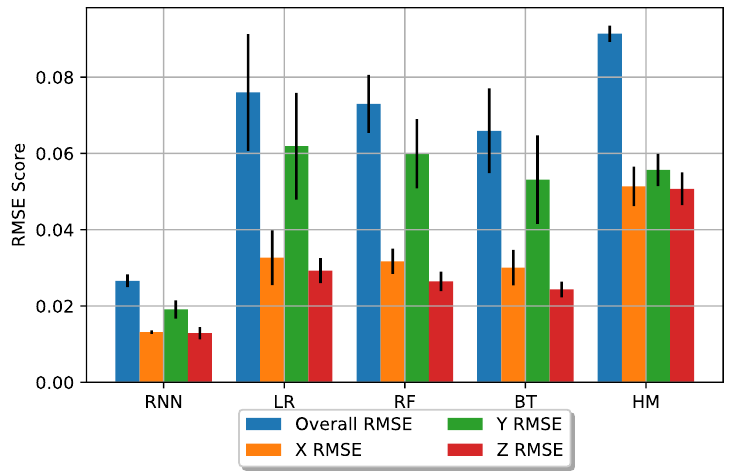
Figure 10. Data-driven models and hybrid-modelling